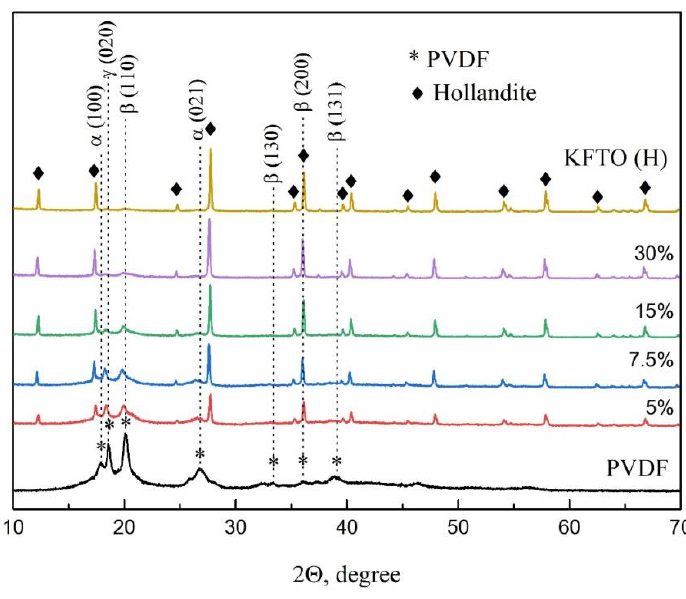
Figure 3. XRD patterns of the KFTO(H)/PVDF composites.